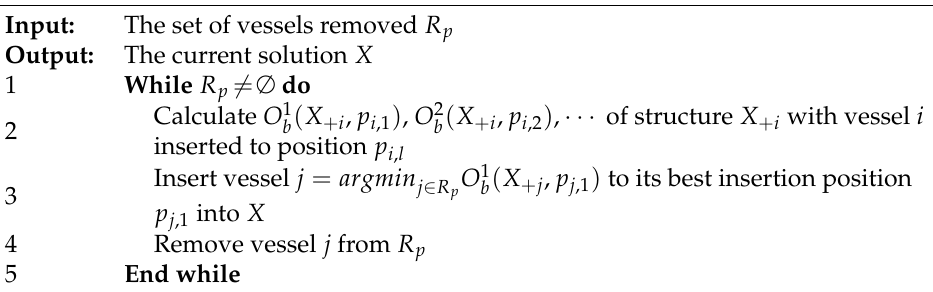
Algorithm 2: Deep greedy repair